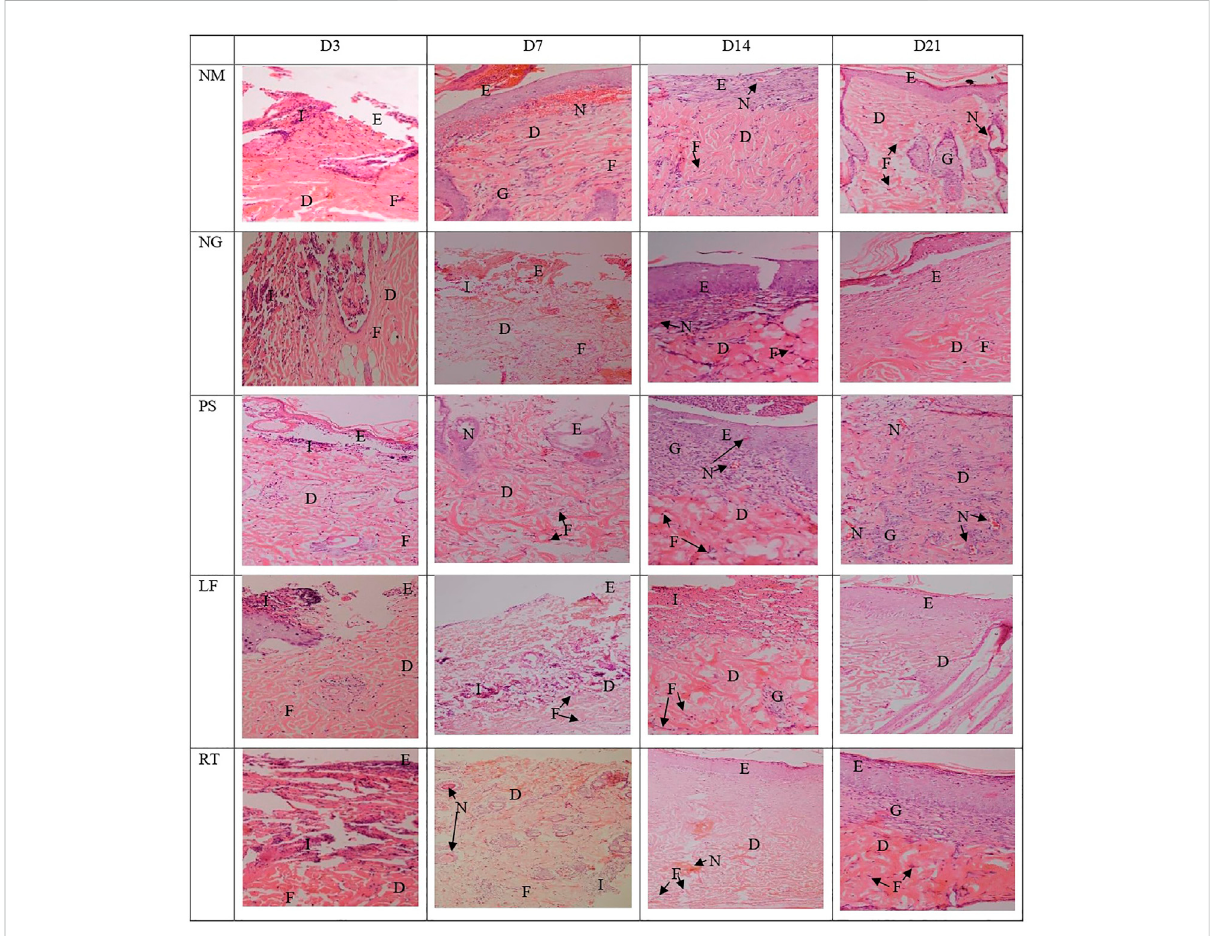
FIGURE 7 Histopathological view of the burn wounds at Day 3, 7, 14 and 21. Stained with H&E, at ×200 magni fi cation. At day 3, a complete destruction of epidermislayerandpartialdestructionofdermislayerwereobservedinallgroups,withmoderatein fl ammatorycellsandscant fi broblastcells.AtDay 21, the re-epithelization in most groups were improved, with abundant fi broblast proliferation, neo-vascularization, and granulation tissue in fi ltration. E: Epidermis; D: Dermis; I: In fl ammatory cells; F: Fibroblast cells, G: Granulation tissue; N: Neovascularization. NM: normal control group, NG: negative control group, PS: positive control group, LF: LPVa leaf-treated group, RT: LPVa root-treated